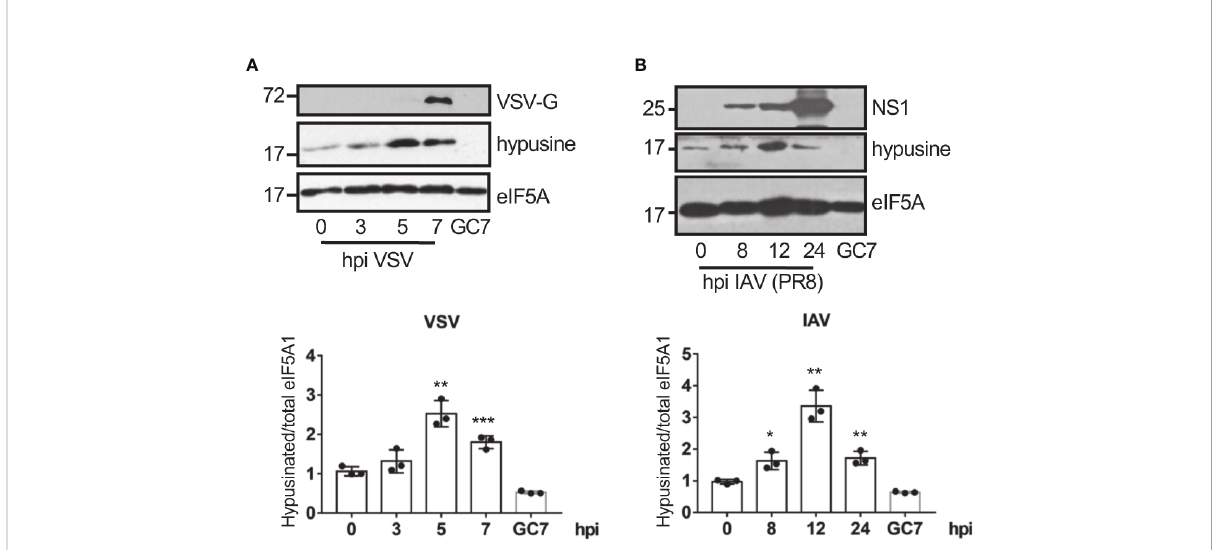
FIGURE 1 Virus infection induces eIF5A activation. Activation of eIF5A in response to VSV (A) or the mouse-adapted in fl uenza A/PR78/34 (PR8) virus (B) infection. Hypusinated eIF5A and protein intensity bands from three biological replicates were quanti fi ed using Image J software. Hypusinated/ total eIF5A ratio from each respective time were plotted. Data represent the mean and error bars of three biological replicates (lower panels). Statistical analysis was assessed by a Student ’ s t-test. *, P < 0.05; **, P < 0.005; ***, P <